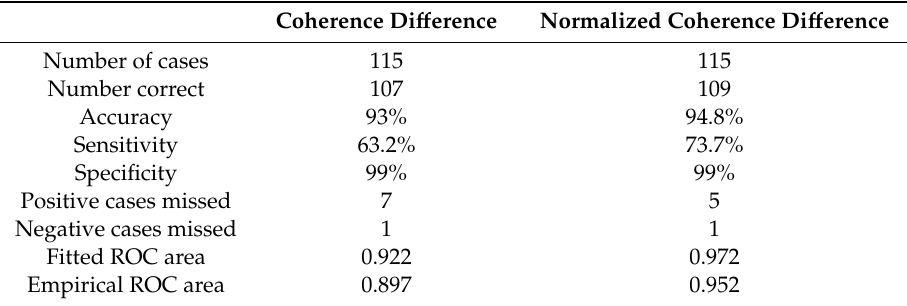
Table 2. Receiver Operating Characteristic (ROC) summary